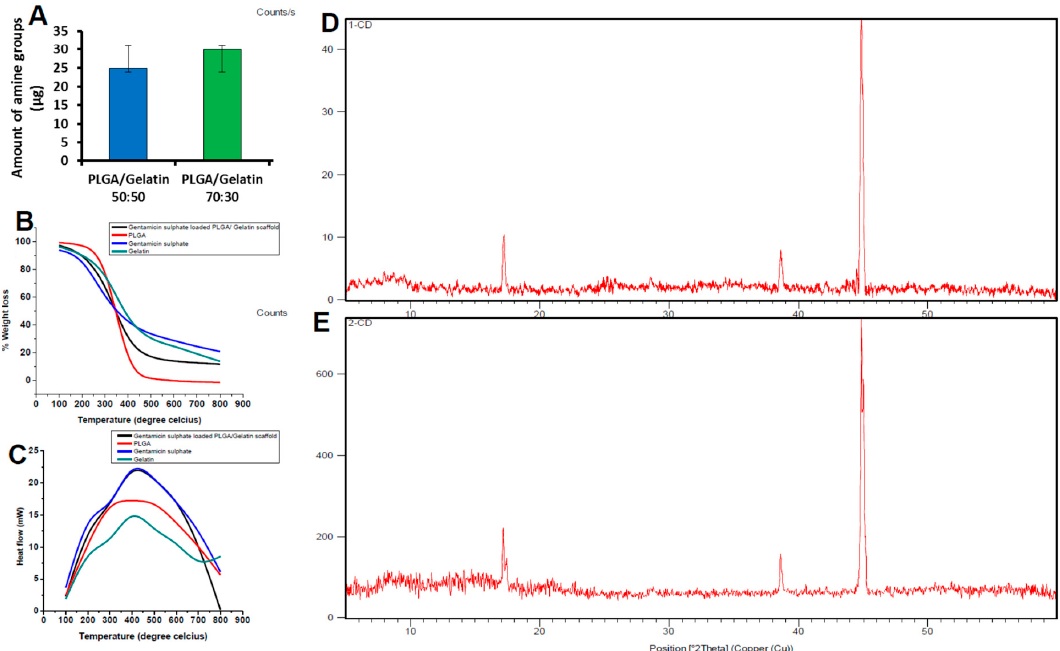
Figure 3. Biochemical characterization. ( A ) 2,2-dihydroxyindane-1,3-dione (ninhydrin) assay